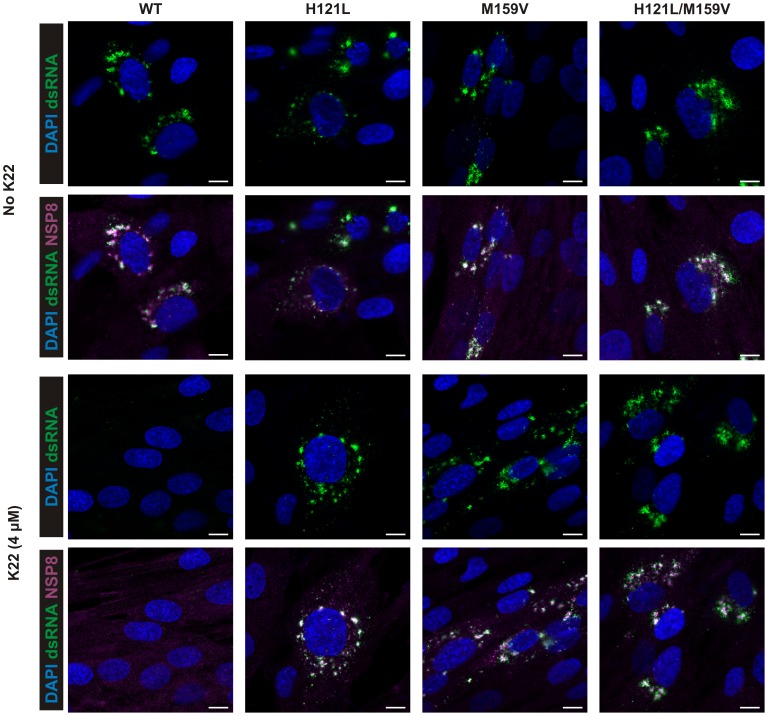
K22 affects formation of coronavirus replication complex in cells.MRC-5 cells were infected with wild type HCoV-229E (WT) and K22-resistant recombinants HCoV-229EH121L (H121L), HCoV-229EM159V (M159V), and HCoV-229EH121L/M159V (H121L/M159V) and incubated for 18 h with or without the presence of K22. The cells were then fixed with 4% paraformaldehyde and immunostained for immunofluorescence analysis. Note the lack of detection of dsRNA and nsp8 upon K22 treatment (4 µM) of cells infected with WT but not recombinant viruses. Scale bar is 10 µM.